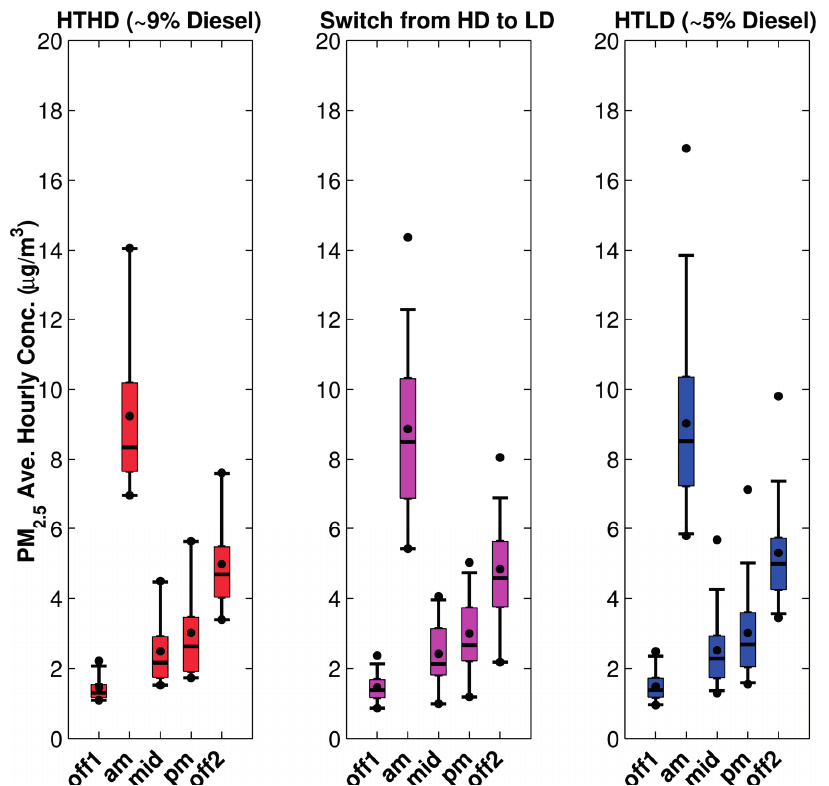
Figure 12. Average hourly pollutant concentrations for PM separated into HTHD, HTLD, and LT after adjusting traffic volume and fleet mix used in the modeling. HT study participants’ whose home locations were reclassified from HD to LD are shown in magenta between the HTLD and HTLD